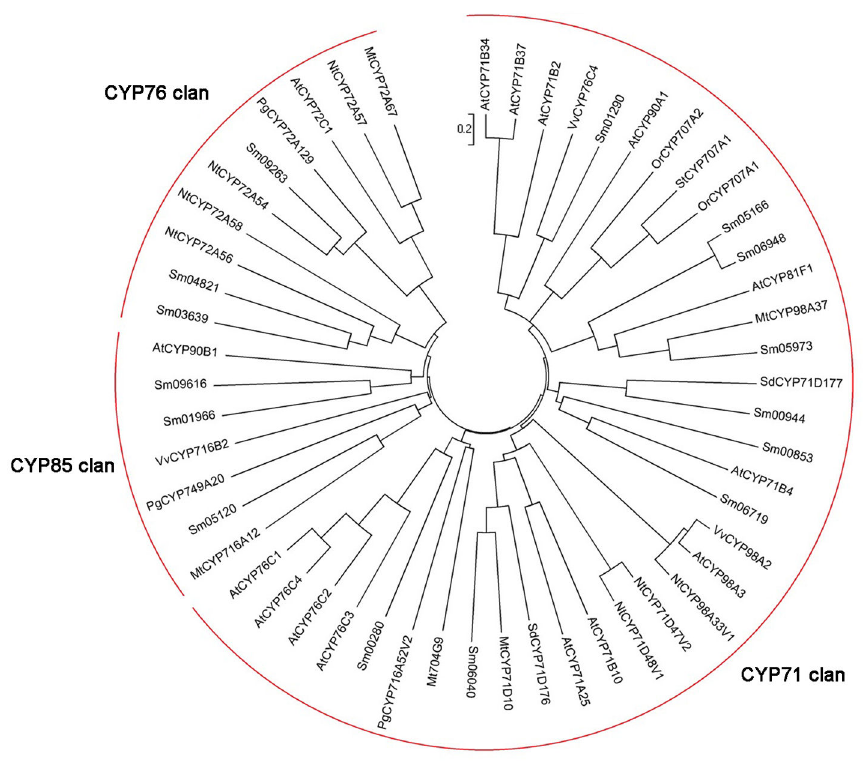
Figure 5. Phylogenetic analysis of CYP450s from S. miltiorrhiza and other plants. Amino acid sequences were aligned using CLUSTALW program, and evolutionary distances were calculated using MEGA4 software with the Poisson correction method. Nt, Nicotiana tabacum ; Pg, Panax ginseng ; Mt, Medicago truncatula ; Vv, Vitis vinifera ; Sd, Scoparia dulcis ; Or, Orobanche ramose ; St, Solanum tuberosum ; Sm, Salvia miltiorrhiza . The GenBank/EMBL/DDBJ accession numbers of the sequences are